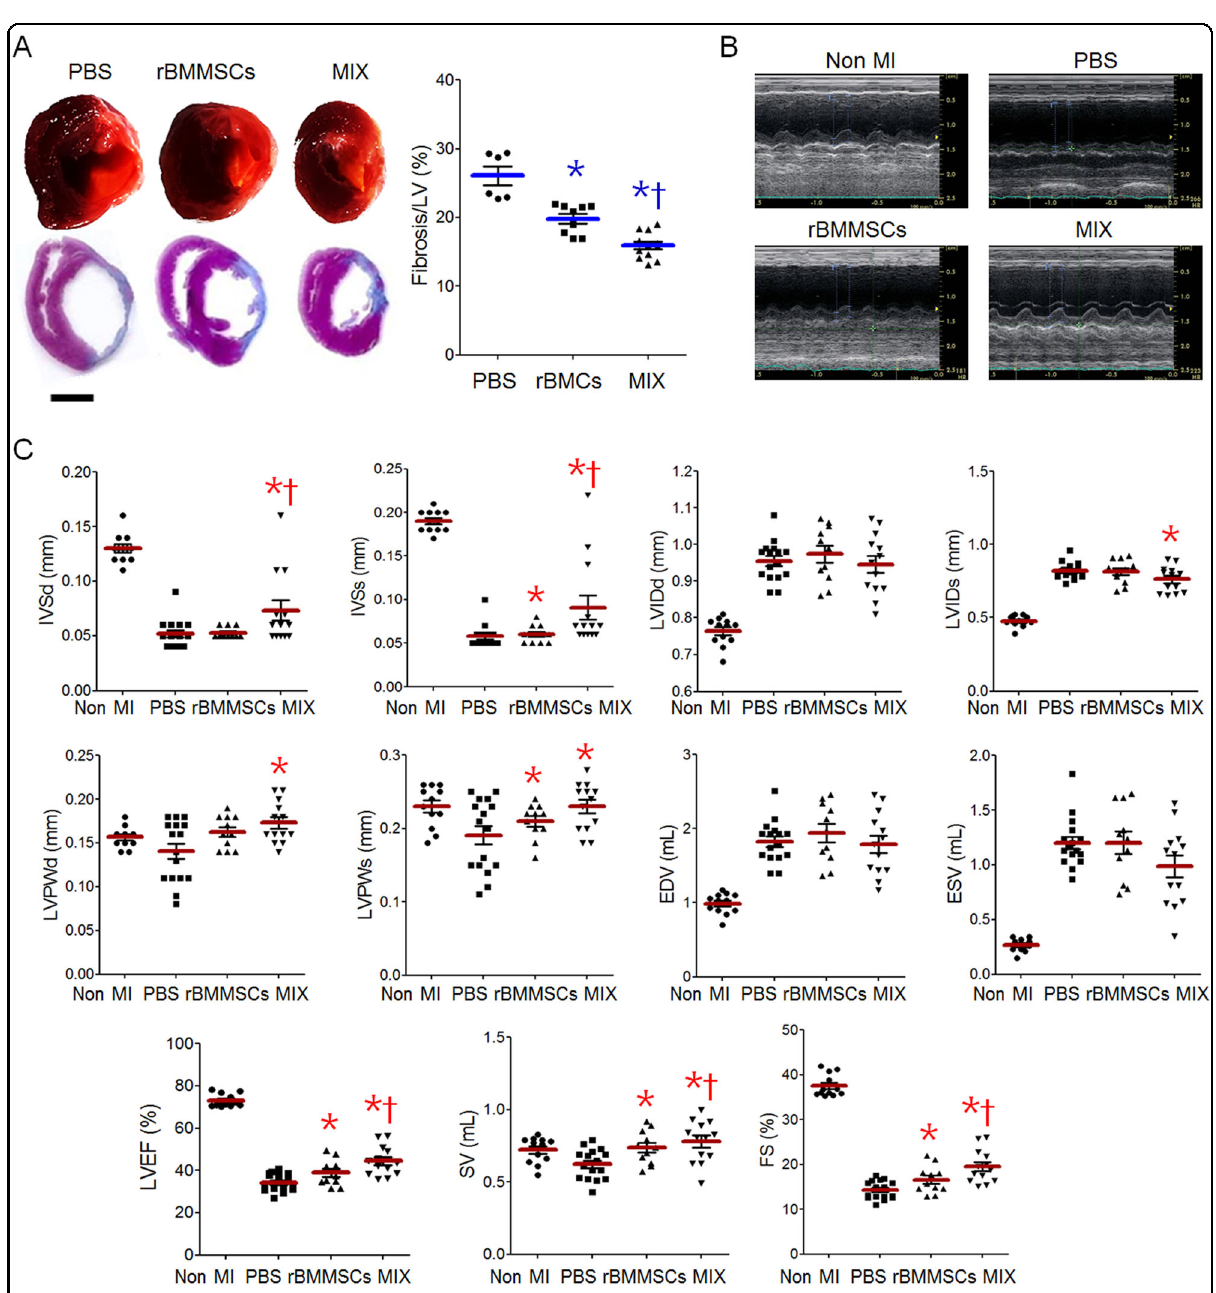
Fig. 3 Therapeutic ef fi cacies of BMCs and MIX in a rat myocardial infarction (MI) model. a Representative gross images (upper) and trichrome- stained heart tissues (lower) from the MI model rats injected with PBS, rBMMSCs, or MIX. Cardiac fi brosis was quanti fi ed (right). b Representative echocardiograms of the non-MI, PBS, rBMMSC, and MIX groups. c The cardiac function indexes were measured by